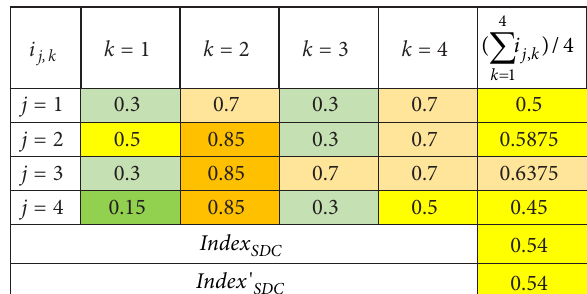
Table 6. The assessment of susceptibility to destruction in combat for MiG-29